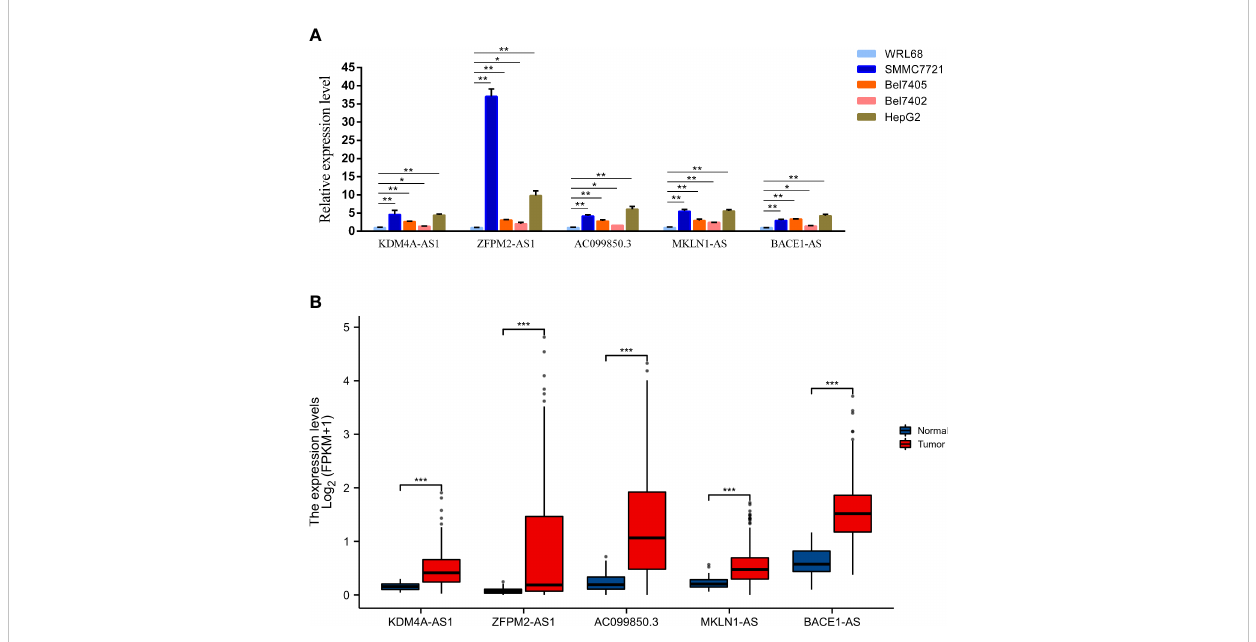
FIGURE 11 (A) Levels of proteins encoded by the fi ve ferroptosis- and necroptosis-related lncRNAs (F-NLRs) in normal hepatocytes and LIHC cell lines, as determined by qRT-PCR. (B) Expression of proteins encoded by the fi ve F-NLRs in the TCGA-LIHC cohort. (* P <0.05, ** P <0.01, *** P